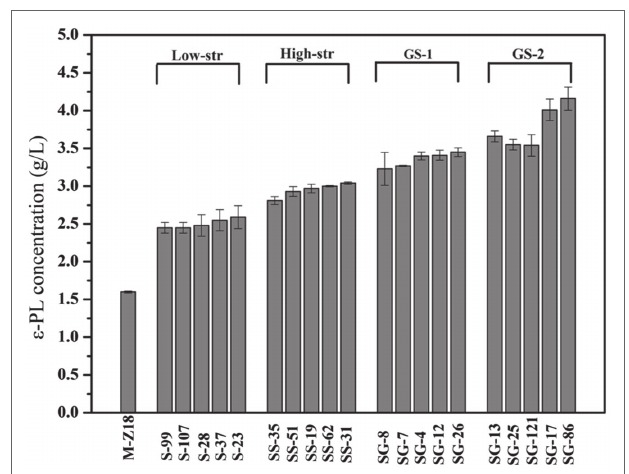
FIGURE 1 | The ε -poly-L-lysine ( ε -PL) production of mutants obtained by streptomycin resistance and genome shuffling (low-str, low streptomycin resistance; high-str, high streptomycin resistance; GS-1, first round of genome shuffling; and GS-2: second round of genome